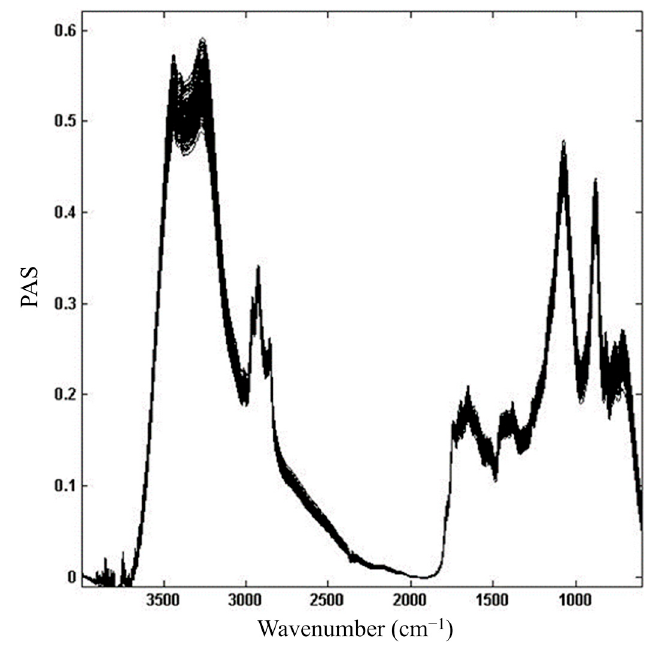
Figure 1. FTIR-PAS spectra of coffees after preprocessing.